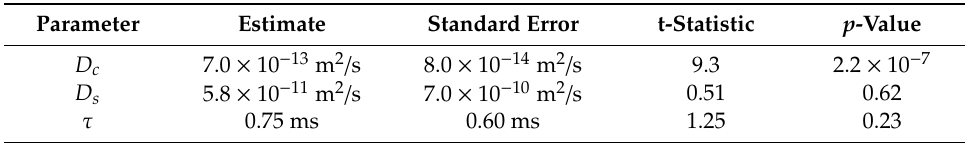
Table 1. Parameters of the effective diffusion model of Equation (9) of the polyethylene melt SRM 1482 at 426 K.